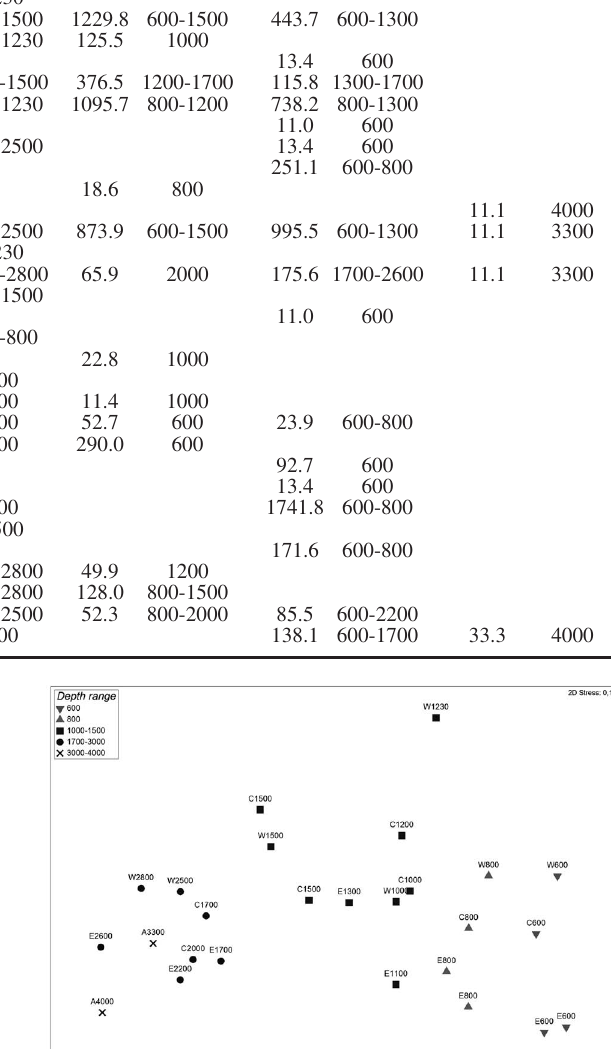
Fig . 2. – Multidimensional scaling plot of the whole abundance dataset. Points are pooled into depth-range groups, for 600-650 m (downward-pointing triangles), 800 m (upward-pointing triangles), 1000-1500 m (squares), 1700-3000 m (circles), and abyssal plain depths at 3300 and 4000 m (crosses). The code letter represents the sampling zone: western Balearic (W), western Ionian (C), eastern Ionian (E) and central abyssal plain